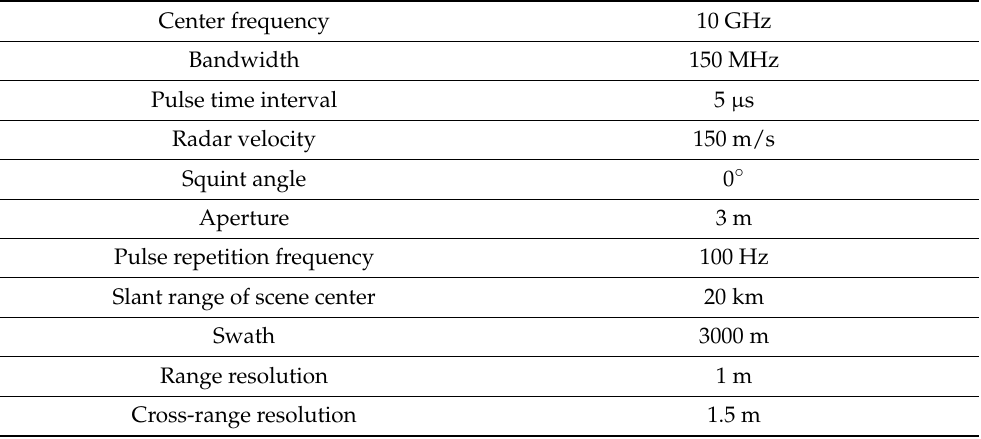
Table 1. Simulation